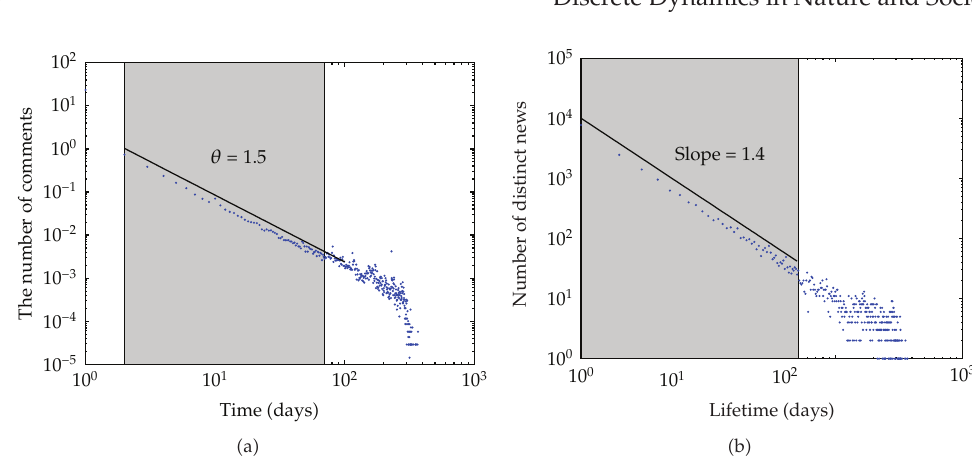
Figure 6: (cid:6) a (cid:7) The number of comments X (cid:6) t (cid:7) for a piece of news as the function of time. (cid:6) b (cid:7) The distribution of news lifetime, which follows a power-law with slope (cid:8) 1.4. All the results are the average over 69440 pieces of news, which have been commented